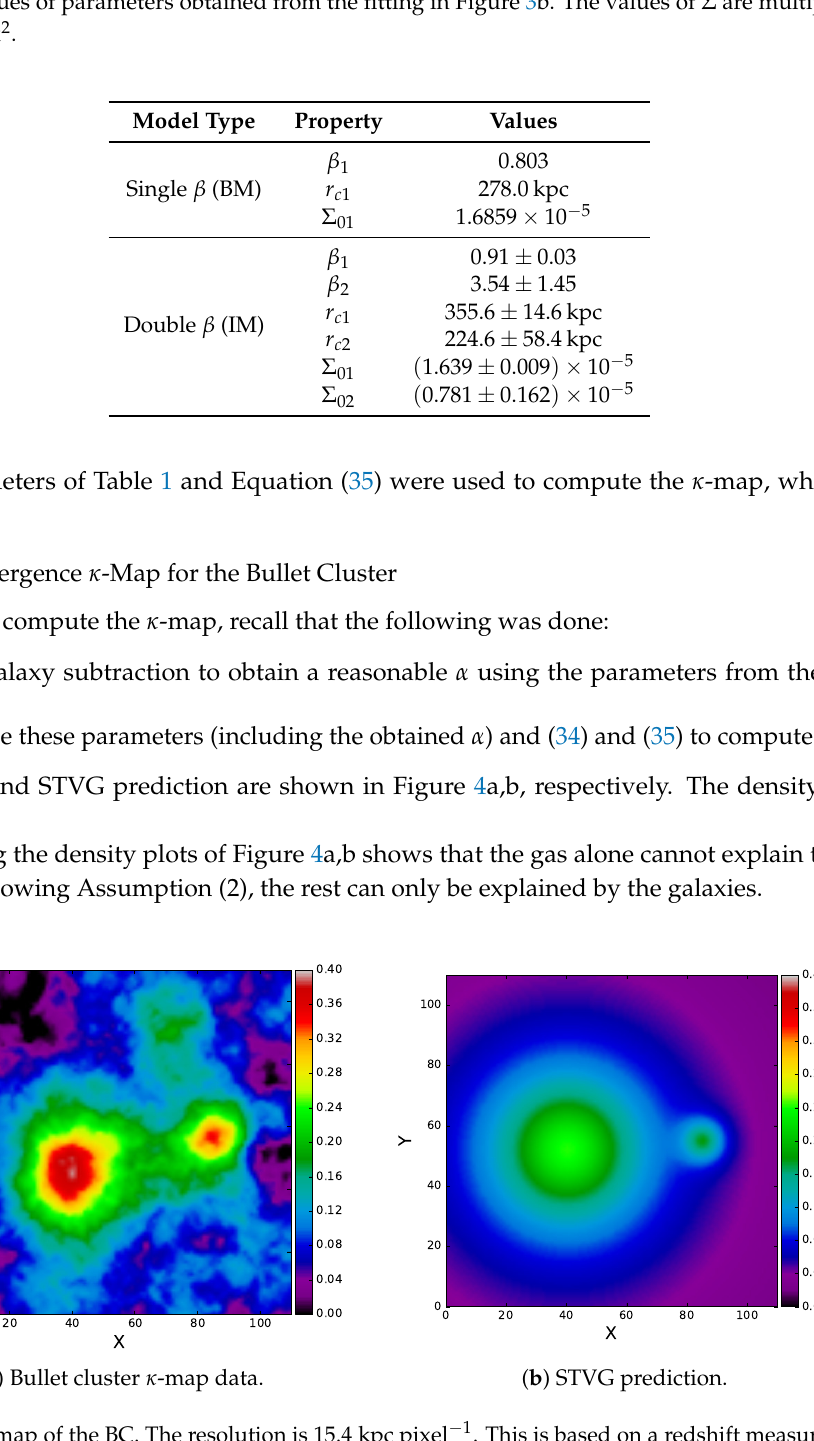
Figure 4. κ -map of the BC. The resolution is 15.4 kpc pixel − 1 . This is based on a redshift measurement of the BC of 260 kpc arcmin − 1